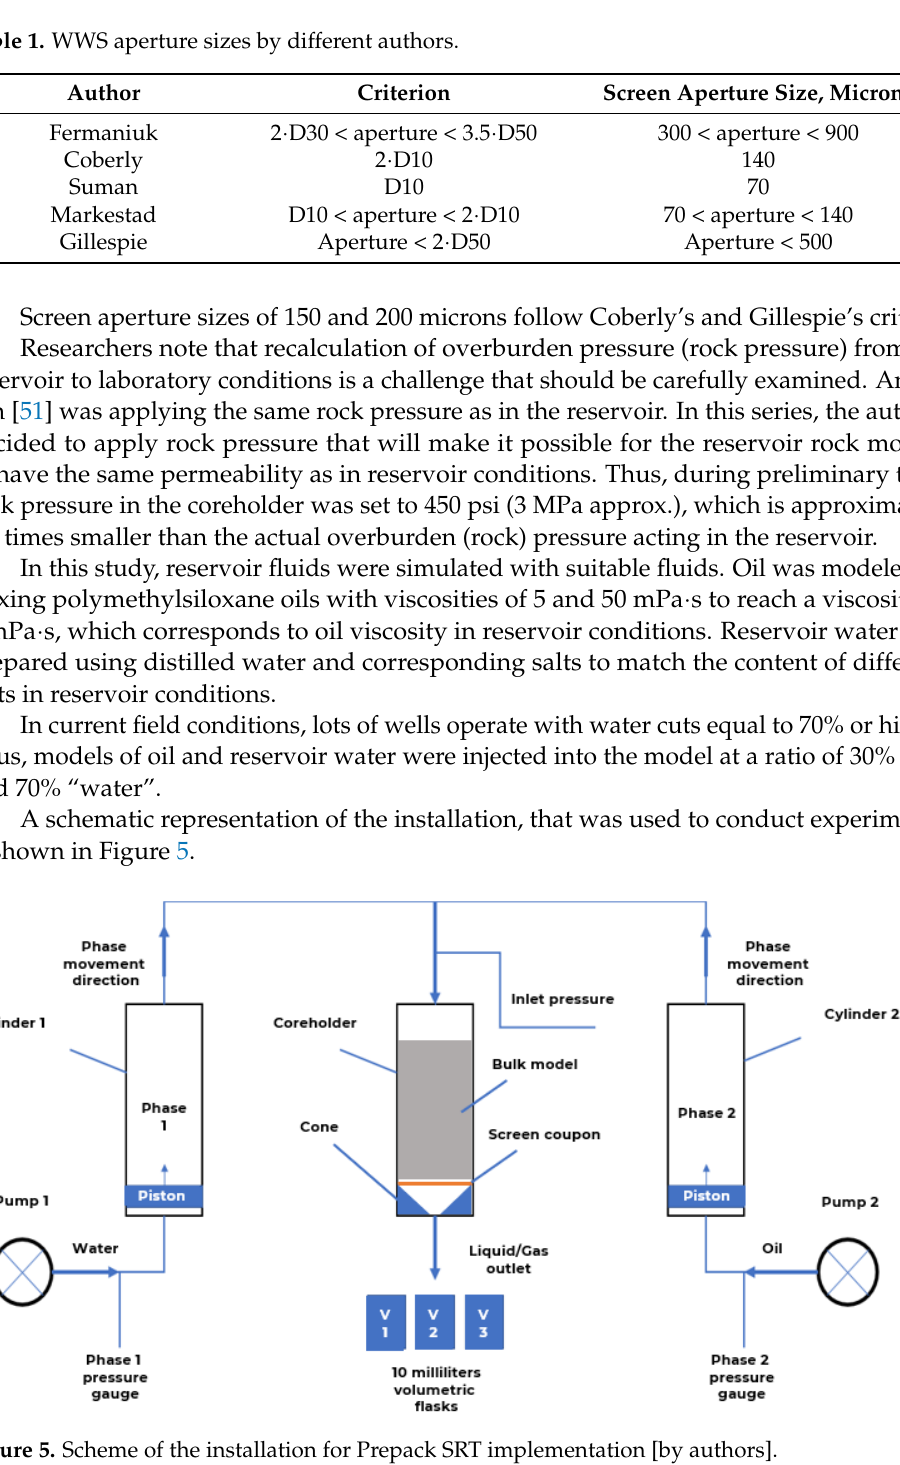
Figure 5. Scheme of the installation for Prepack SRT implementation [by authors].